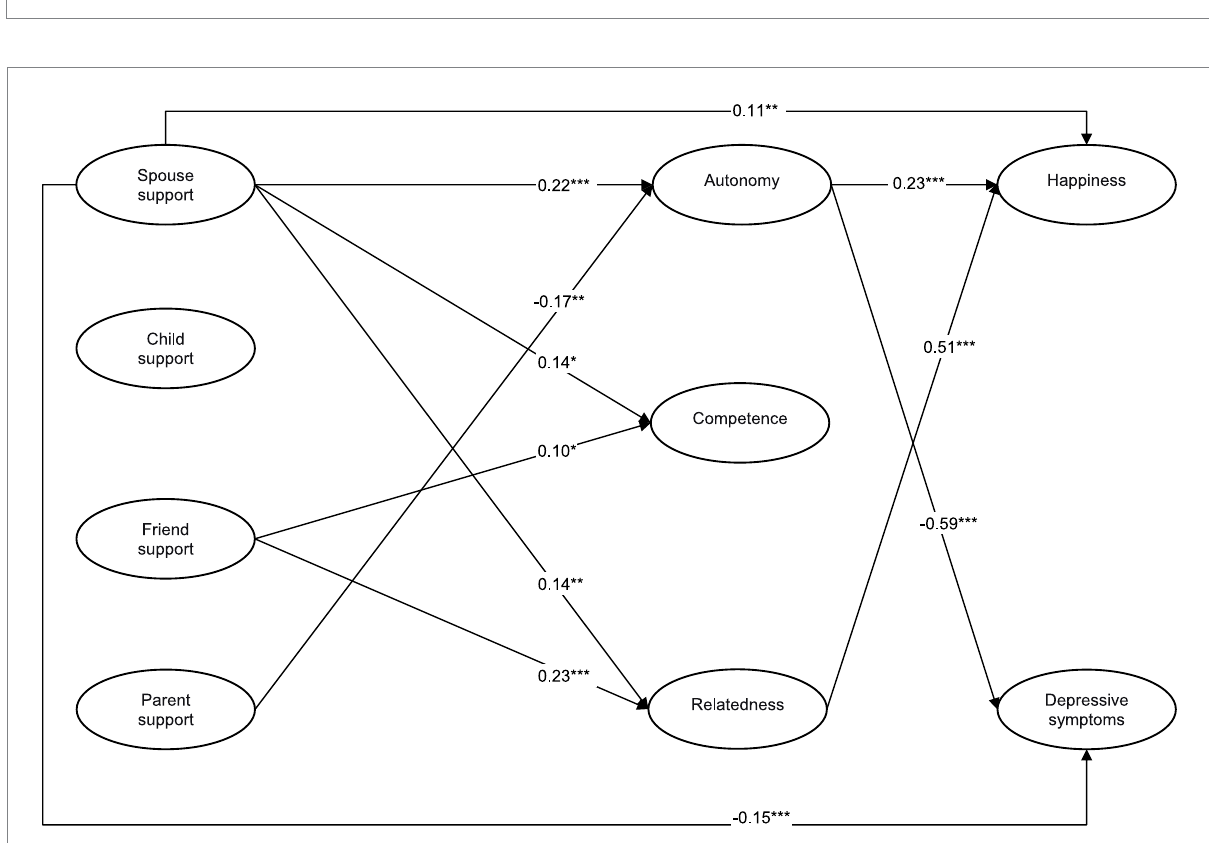
FIGURE 1 The final structural paths on the associations between social support, satisfaction of needs, well-being. The path coefficients before and after the slash are for younger and older adults, respectively; n = 807; * p < 0.05. ** p < 0.01. *** p < 0.001.